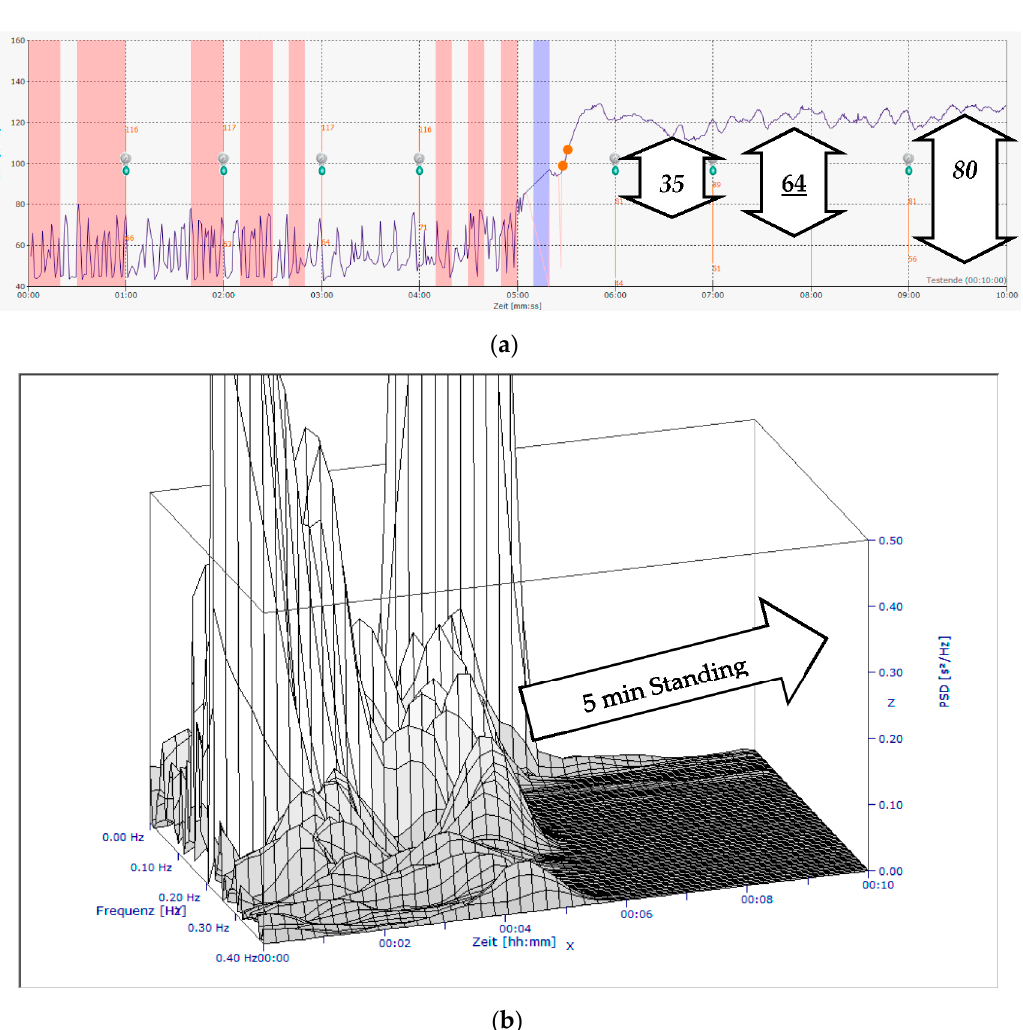
Figure 4. A 13-year-old boy with chronic fatigue after Epstein–Barr virus infection and postural orthostatic tachycardia syndrome: ( a ) The original heart rate raw data: the software calculates an average increase in heart rate of 64 bpm (POTS cut-off is 35 bpm), as used in the current analysis. Frequently used point measurements (could be over 80 bpm—or underestimated at 35 bpm) for the heart rate increases due to the pronounced respiratory sinus arrhythmia in many adolescents. ( b ) The monitoring of heart rate variability with the power spectral analysis clearly demonstrates the nearly complete collapse of heart rate variability while standing, which affects almost all frequen- cies.